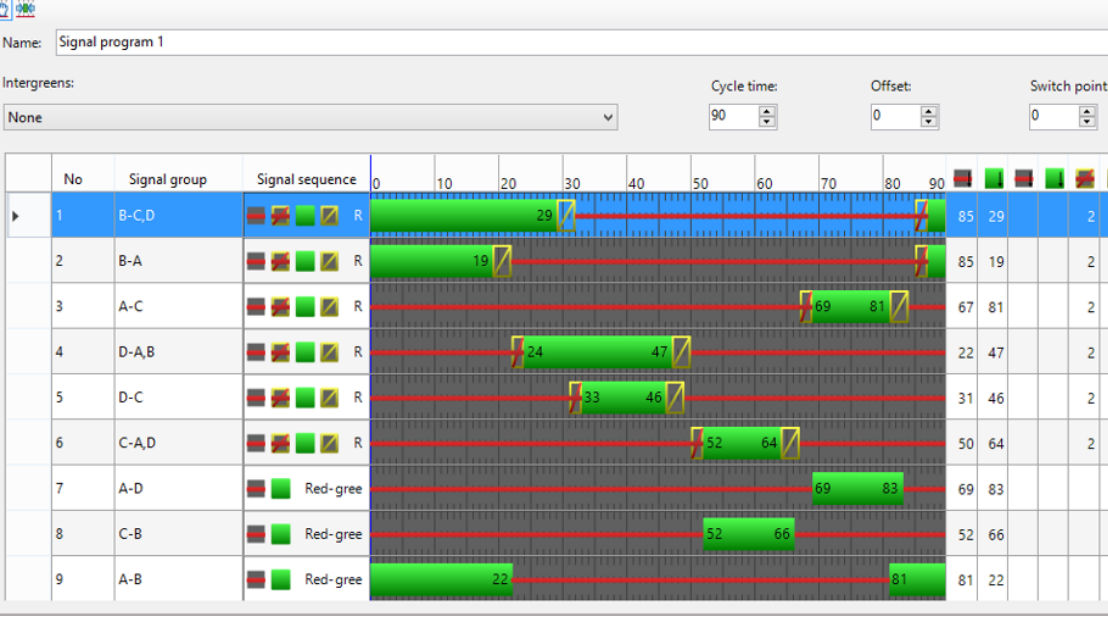
Figure 6: Signal program - current status